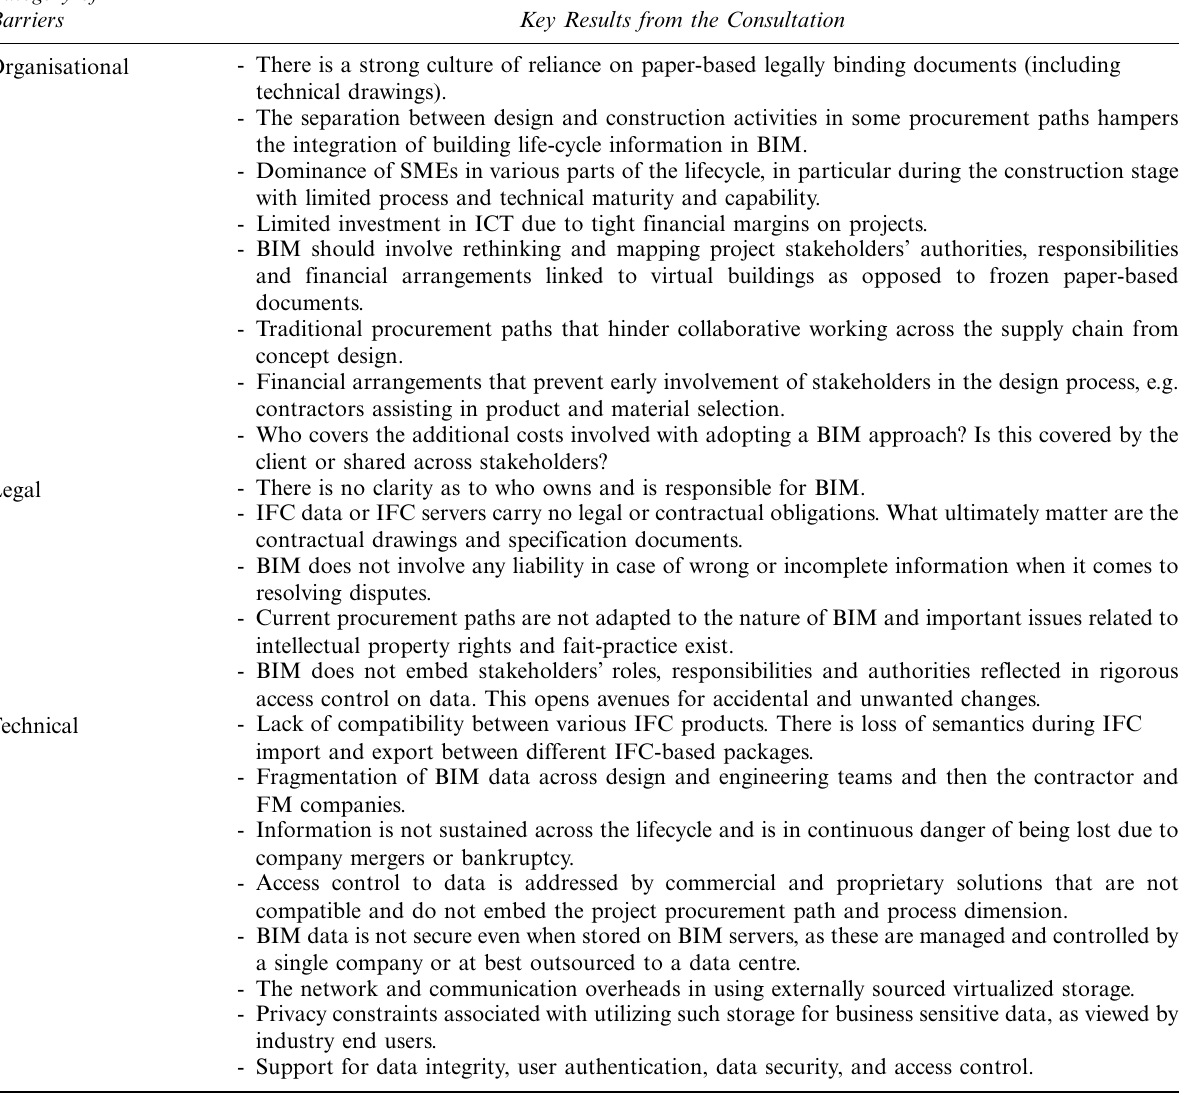
Table 1. Key results from our consultation Category of Barriers Key Results from the Consultation Organisational